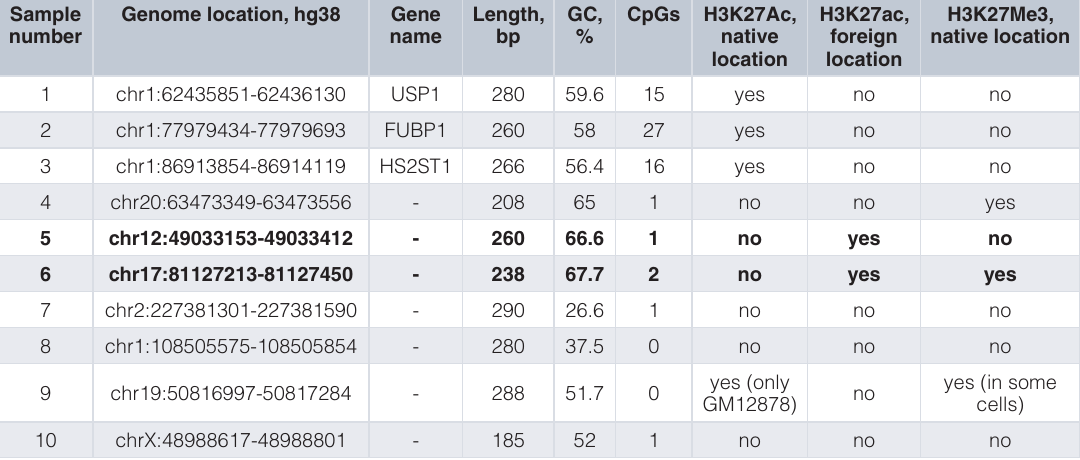
Table 1. Sequences inserted to foreign genomic context and their